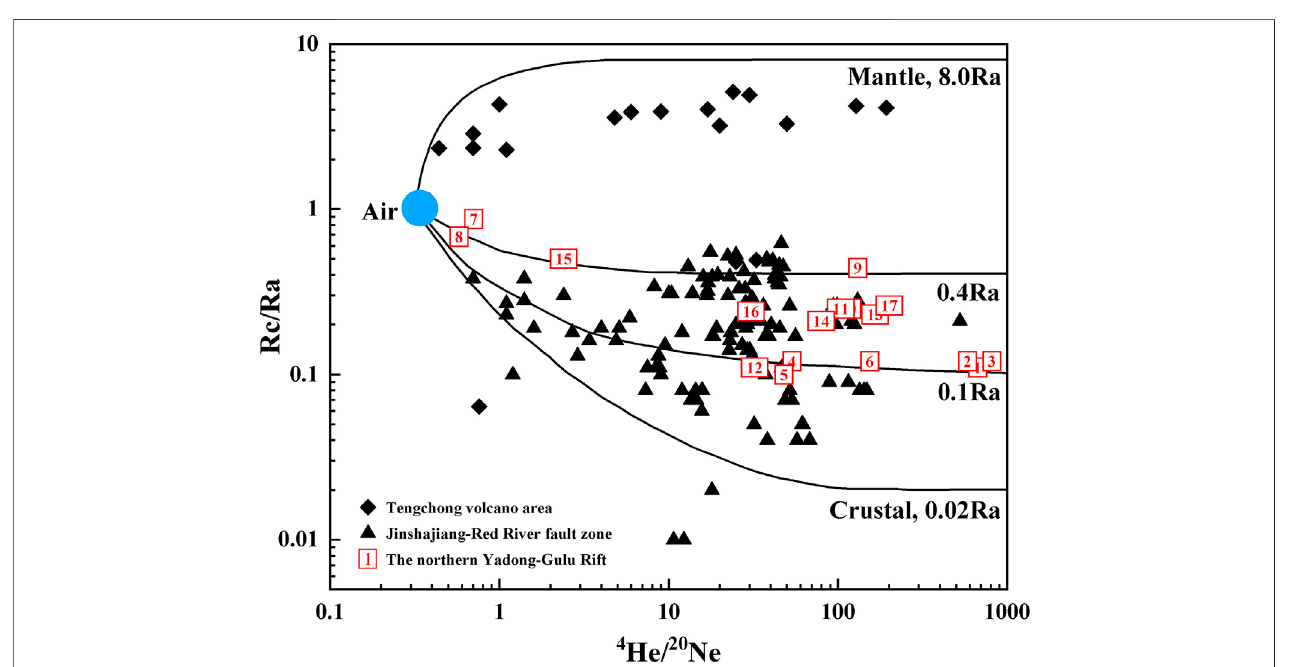
FIGURE 2 | Diagram of Rc/Ra versus 4 He/ 20 Ne. The Rc/Ra and 4 He/ 20 Ne ratios ’ end-members are as follows: air helium: Rc/Ra = 1, 4 He/ 20 Ne = 0.318; crustal helium: Rc/Ra = 0.02, 4 He/ 20 Ne = 1000; mantle helium: Rc/Ra = 8, 4 He/ 20 Ne = 1000 (Sano and Wakita, 1985; Sano and Marty, 1995). Data of the Tengchong volcanic area and Jinshajiang-Red River fault zones are cited from Wang et al. (1993) and Zhou et al. (2020),